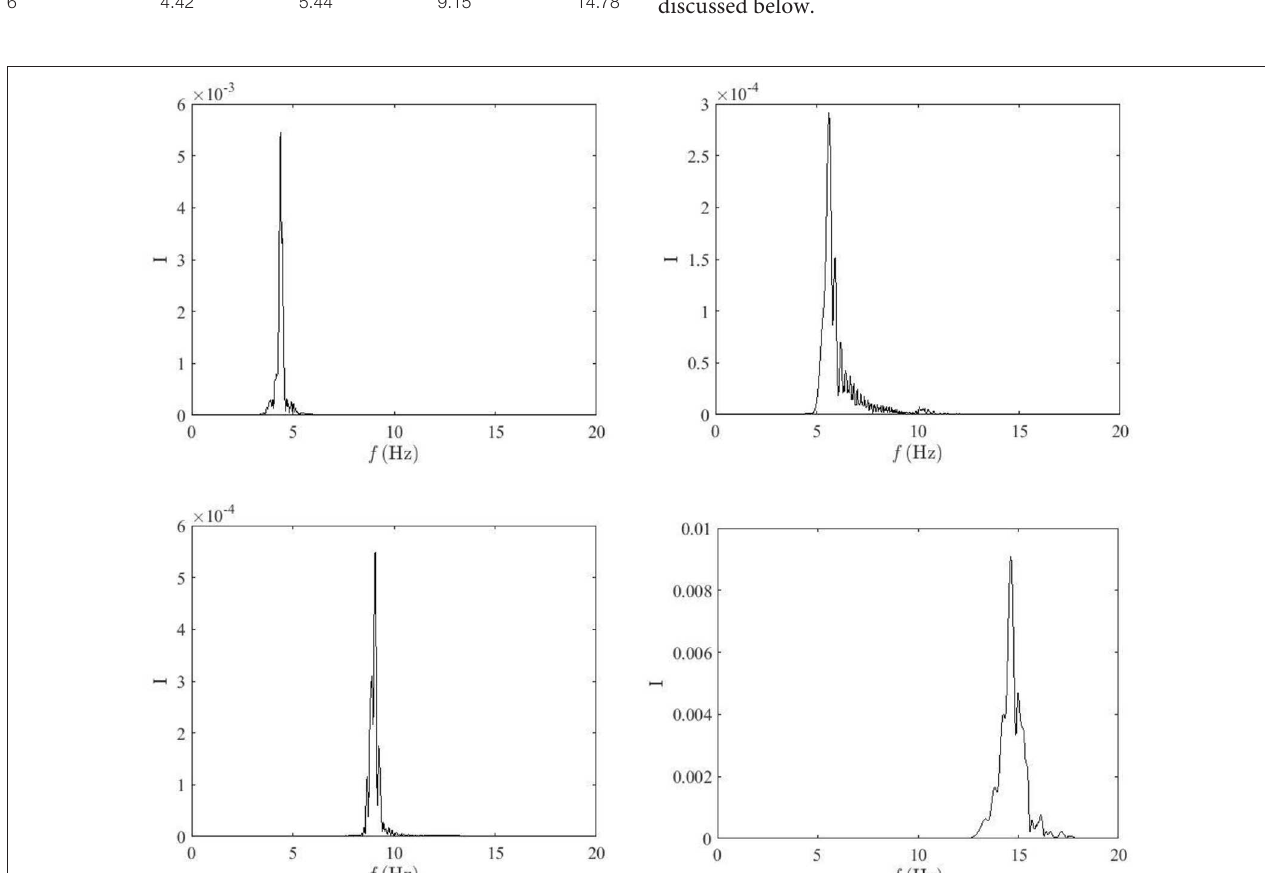
FIGURE 12 | Fourier spectra of mono-component modal responses obtained from TVF-EMD.